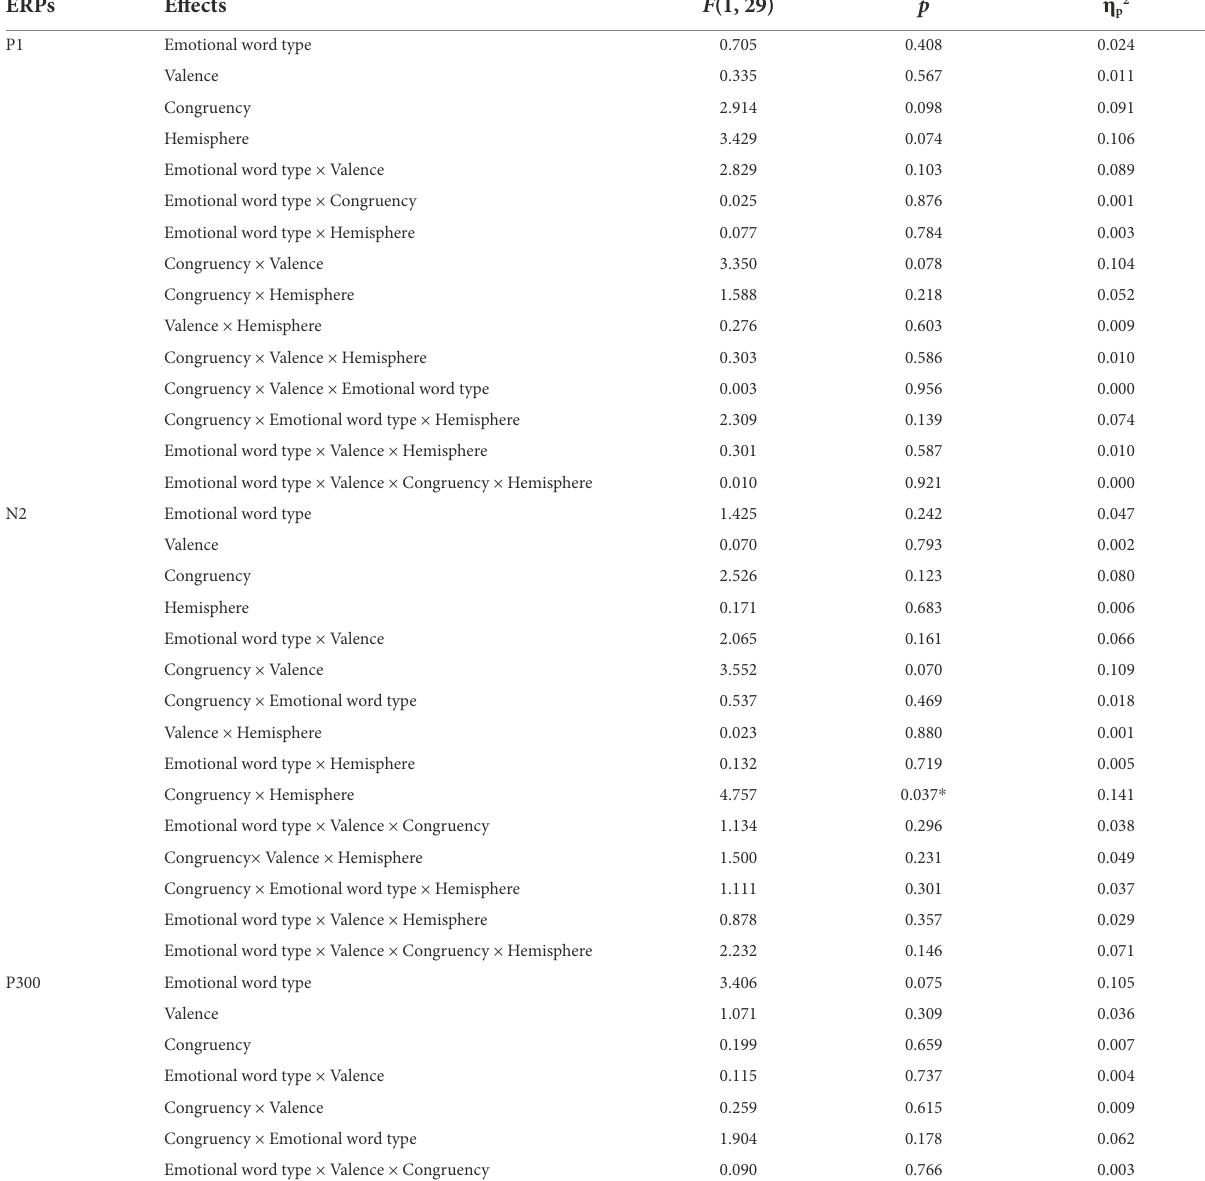
TABLE 5 The ERP results of the target in the